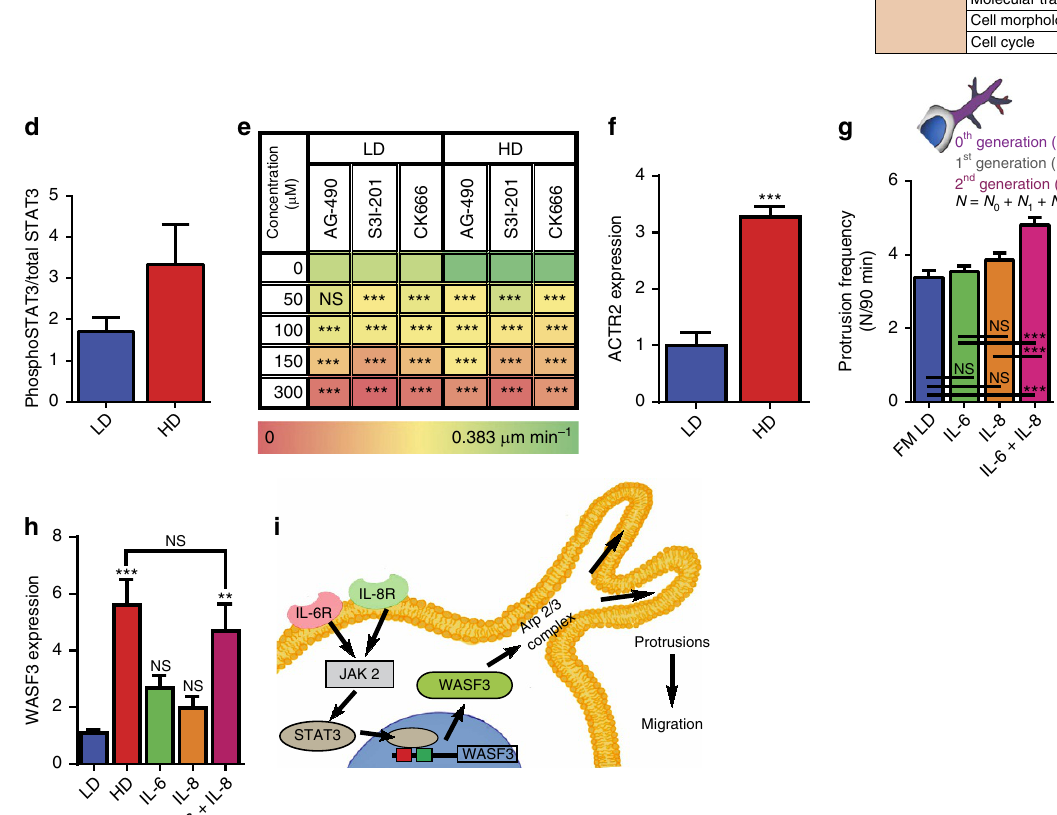
NATURE COMMUNICATIONS|8:15584|DOI: